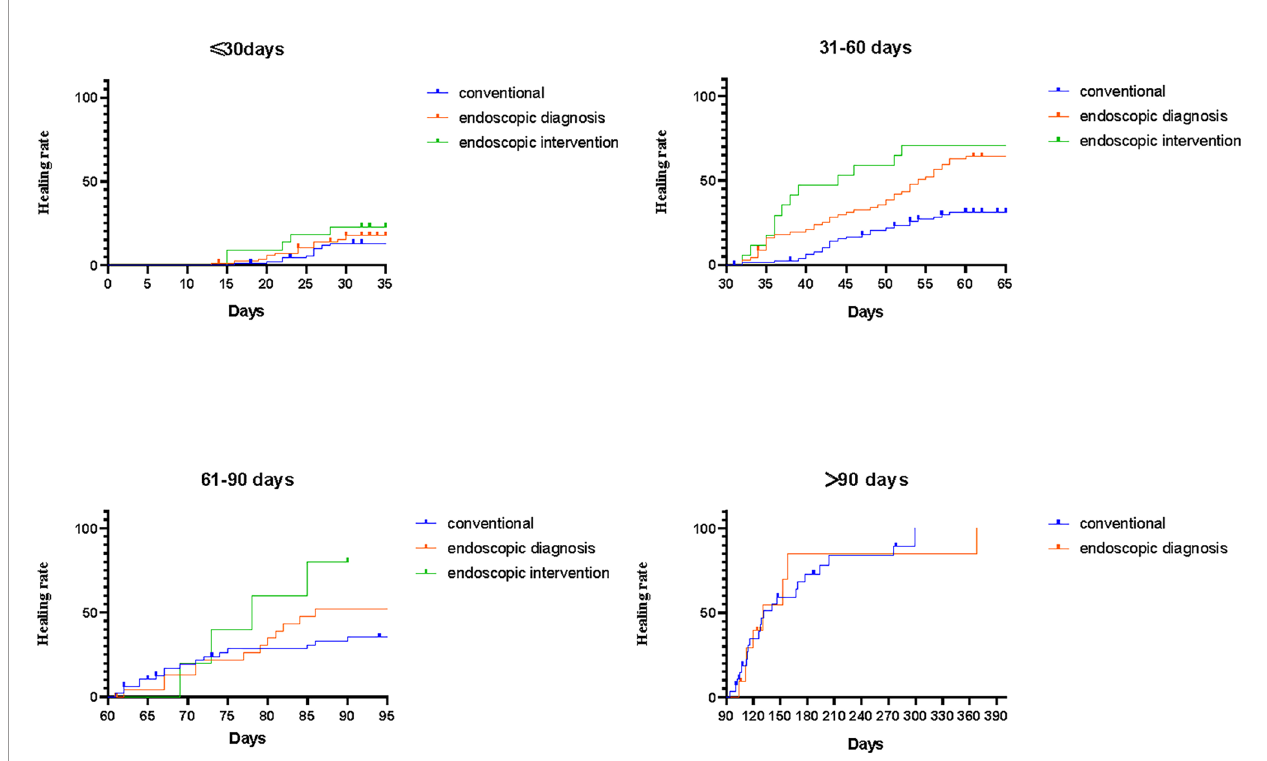
FIGURE 3 | The survival curves of Interventional vs. Endoscopic groups at different landmark